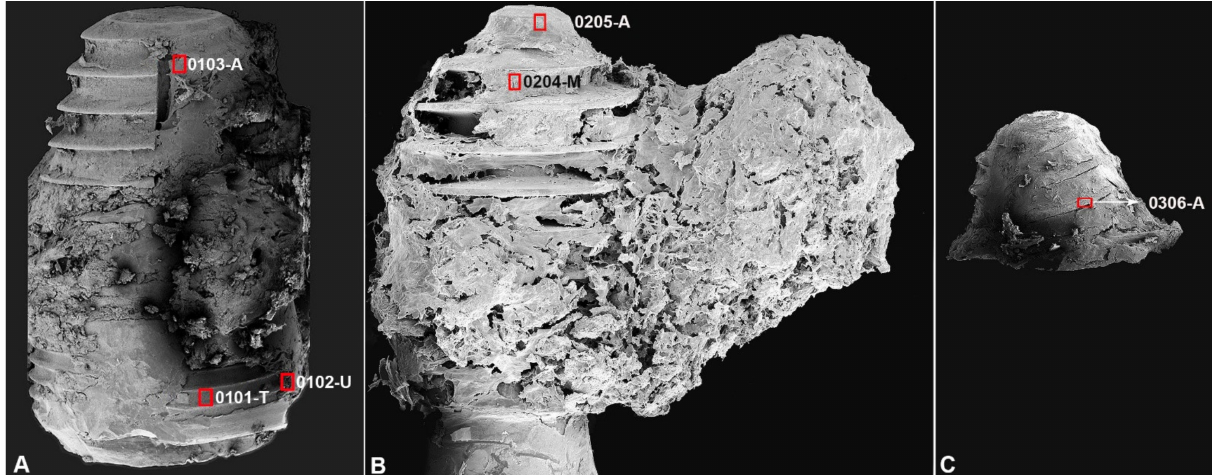
Figure 4. SEM photograph showing the whole implant specimens with the marking of SEM-EDS examined points. In the implant fixture from case 1, the high magnification micrograph and EDS analysis were performed at three points: one in the thread surface to show the fixture morphology (0101-T), one on the attached bone in the upper region (0102-U), and one on the attached bone in the apical region (0103-A), to compare the bone structure and chemical composition at these two regions ( A ). In implant fixture and attached bone mass from case 2, two points in the apical area of the implant, one on the integrated bone in the middle of the fixture (0204-M), and one on the fixture surface in the apical region (0205-A) were chosen to examine the BRONJ—affected and fungal-infected bone and implant morphology ( B ). In the implant apex from case 3, the exposed surface of the fixture thread was chosen to be analyzed by EDS ( C